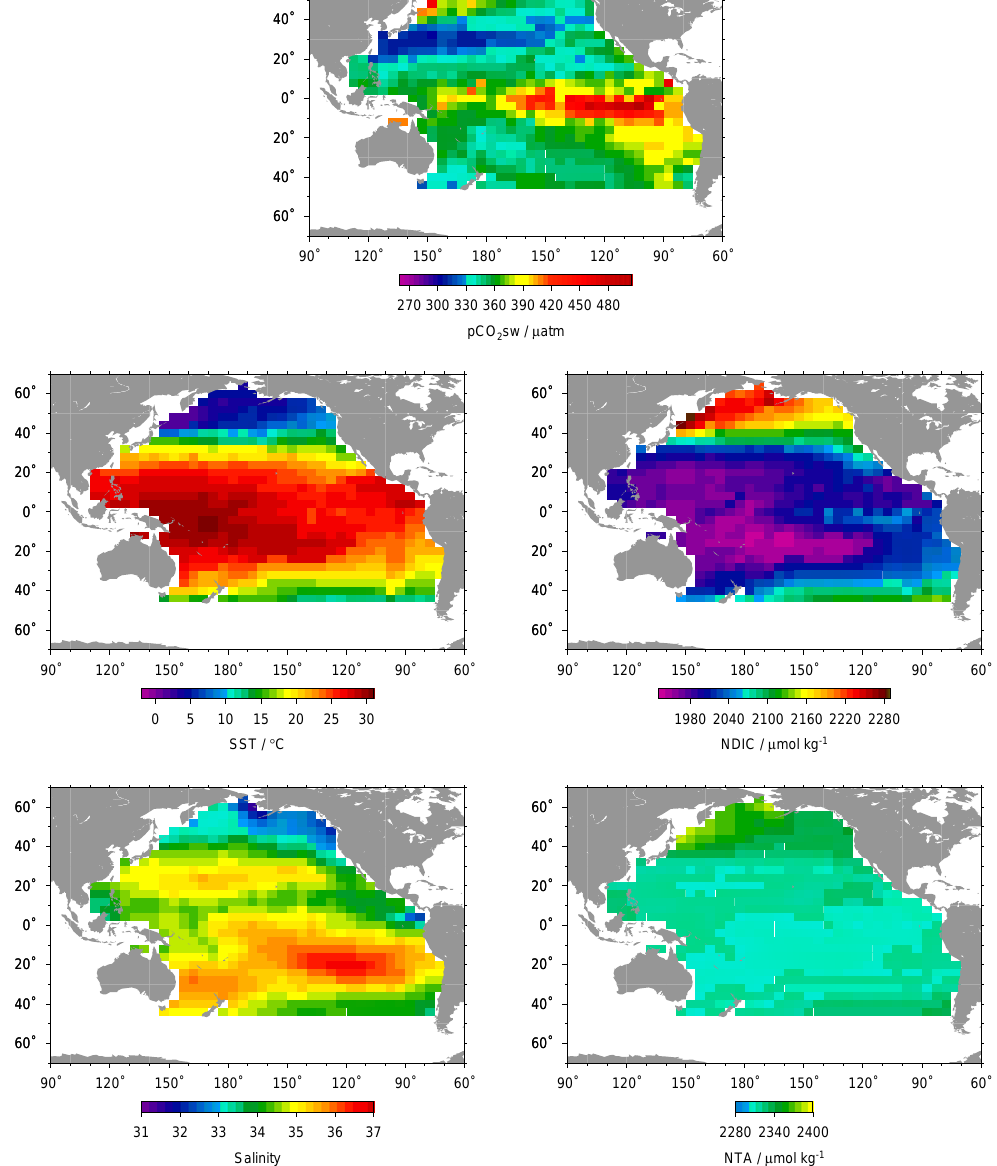
Fig. 1. Data-based climatology in February of p CO 2 sw (top panel), temperature (middle left), salinity (bottom left) from LDEO V2009 (Takahashi et al., 2009a), and salinity-normalized ( S = 35) DIC (middle right) calculated with total alkalinity derived from Lee et al. (2006) (bottom